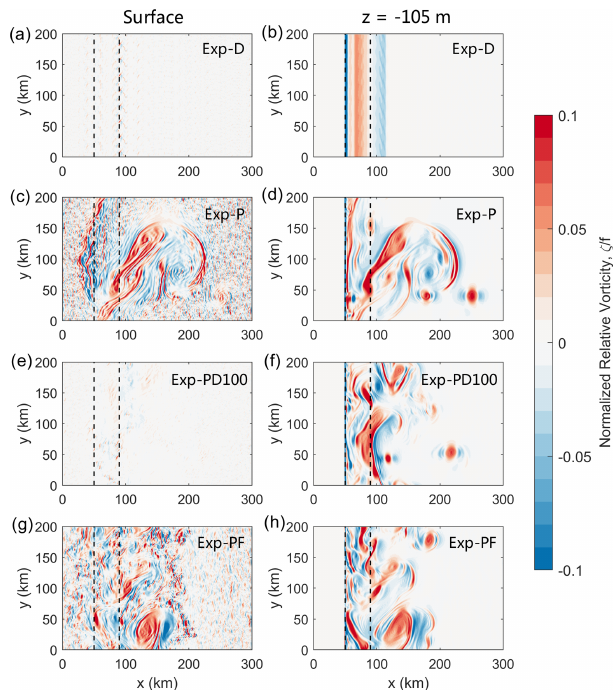
Figure 10. Distributions of the normalized relative vorticity ζ/f from the four sensitivity experiments at t = 180 days: (left) at the surface and (right) at the depth of − 105m. The region of the conti- nental slope is outlined by two dashed black lines in each panel.